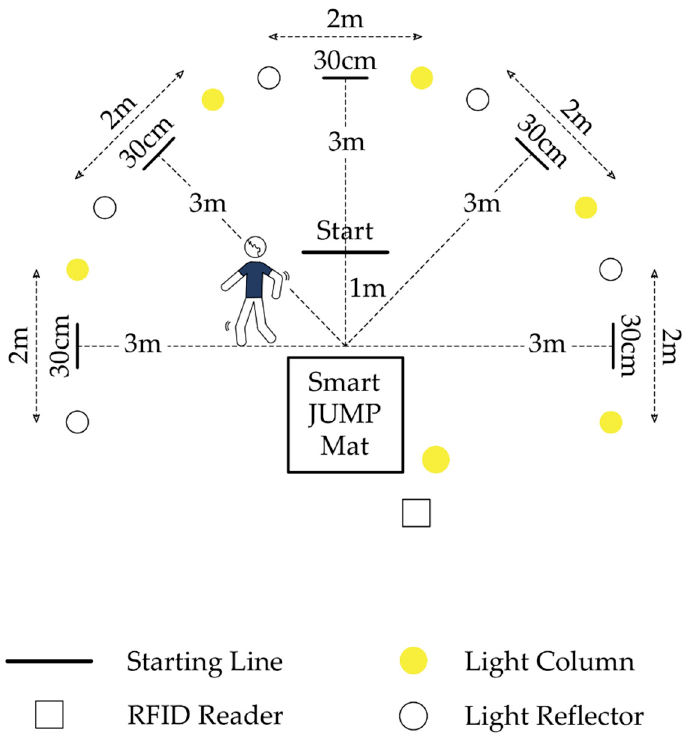
Figure 3. Reactive Shuttle Drill test. At the starting signal, the participant (standing back to the gates) began to run from the starting line to the mat, next to the randomly indicated (through the light) gate, and finally back to the mat (repeating the mat ‐ gate ‐ mat path five consecutive times). Each time, the participant had to (with both feet) cross the tape ‐ marked line in the targeted gate and stand on the mat. The aim was to complete the test as quickly as possible.